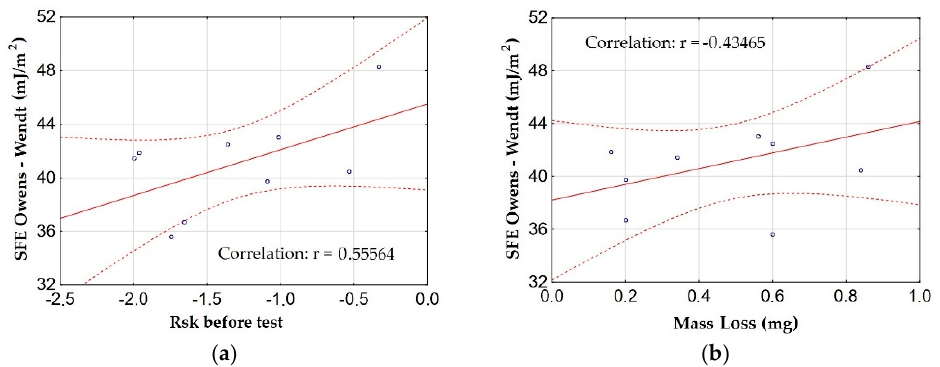
Figure 20. Relationship between SFE and: ( a ) Rsk parameter before the test, ( b ) mass loss of the material.